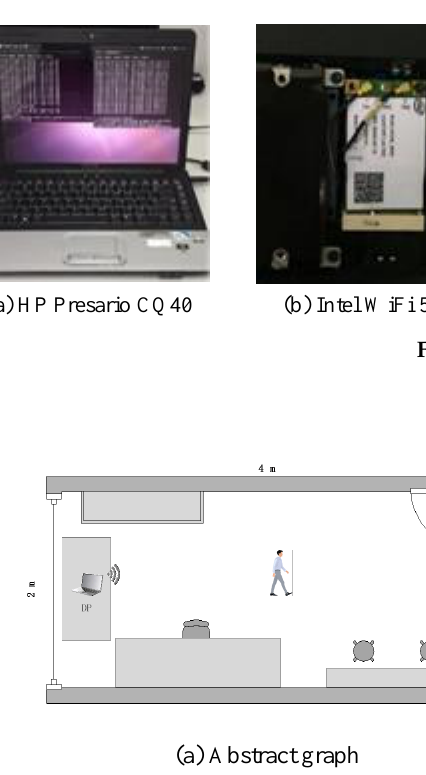
Figure 8. Abstract graph and real picture of experiment